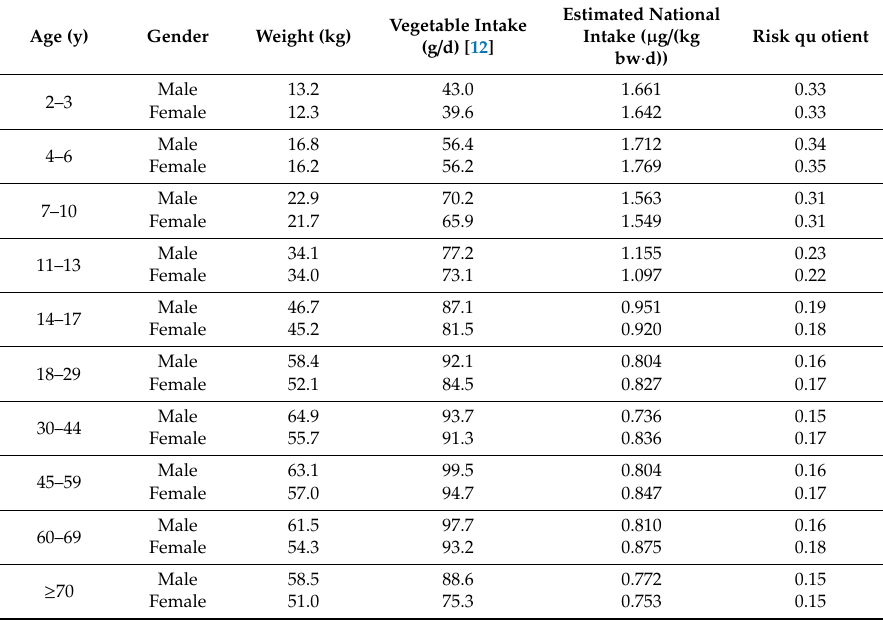
Table 5. Risk assessment of chronic dietary intake of